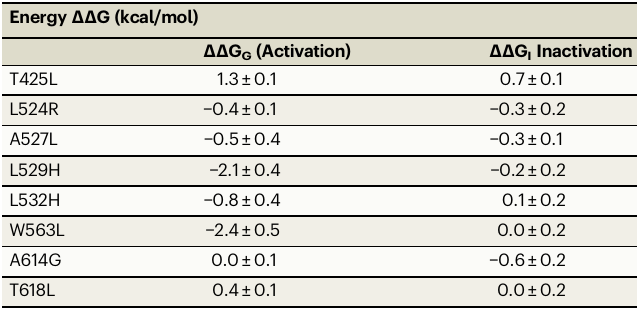
Table 3 | Perturbation of each mutant on the free-energy from G-V and voltage-dependence of inactivation curves Energy ΔΔ G